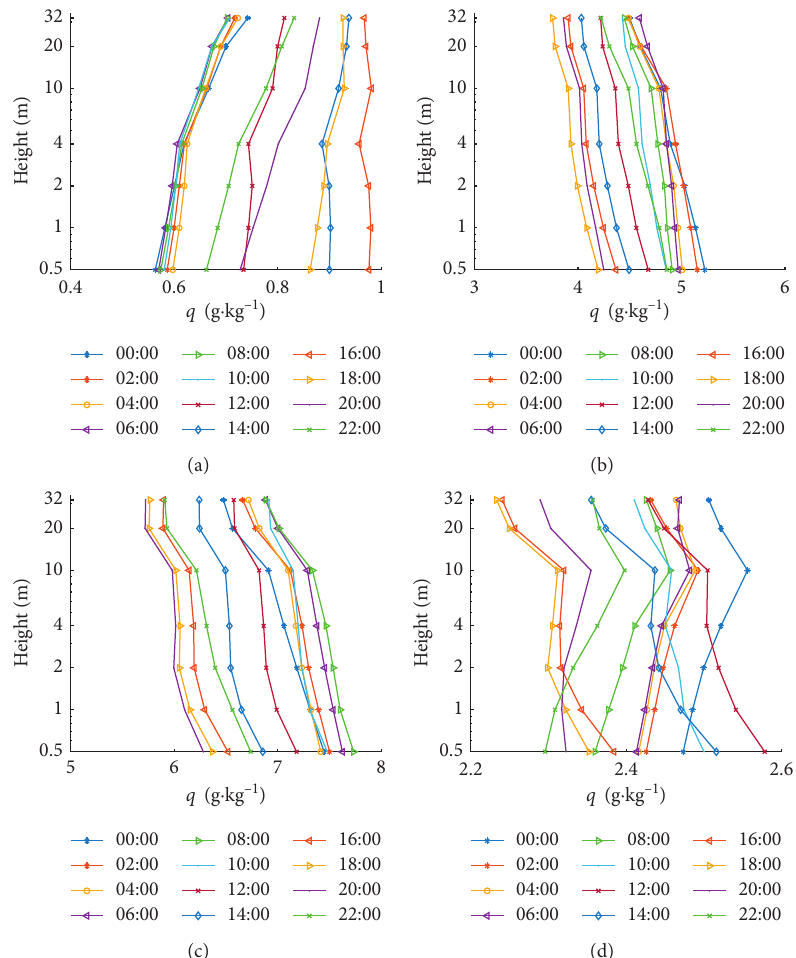
Figure 5: Specific humidity profiles on typical sunny day under the four underlying surface conditions of the Gurbant¨ungg¨ut Desert. (a) Winter. (b) Spring. (c) Summer. (d)